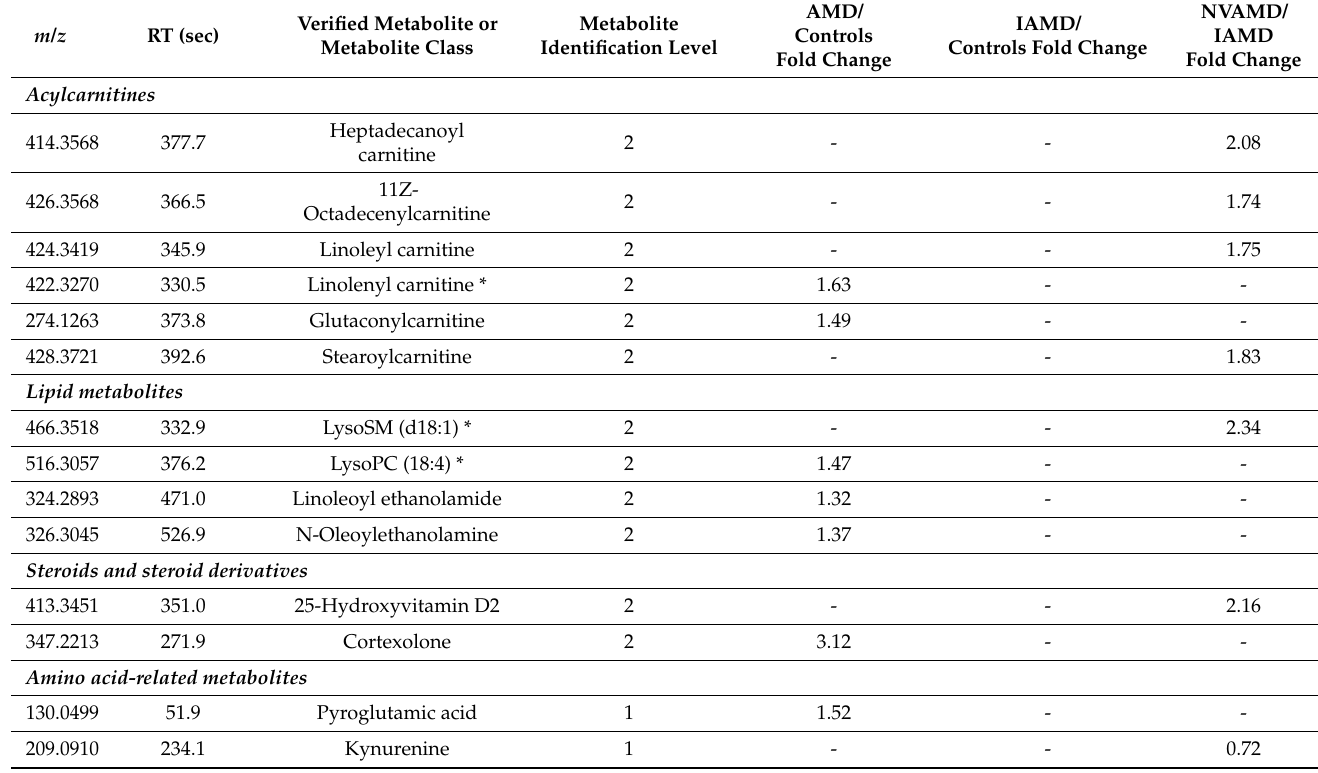
Table 2. Discriminatory metabolic features with confirmed molecular